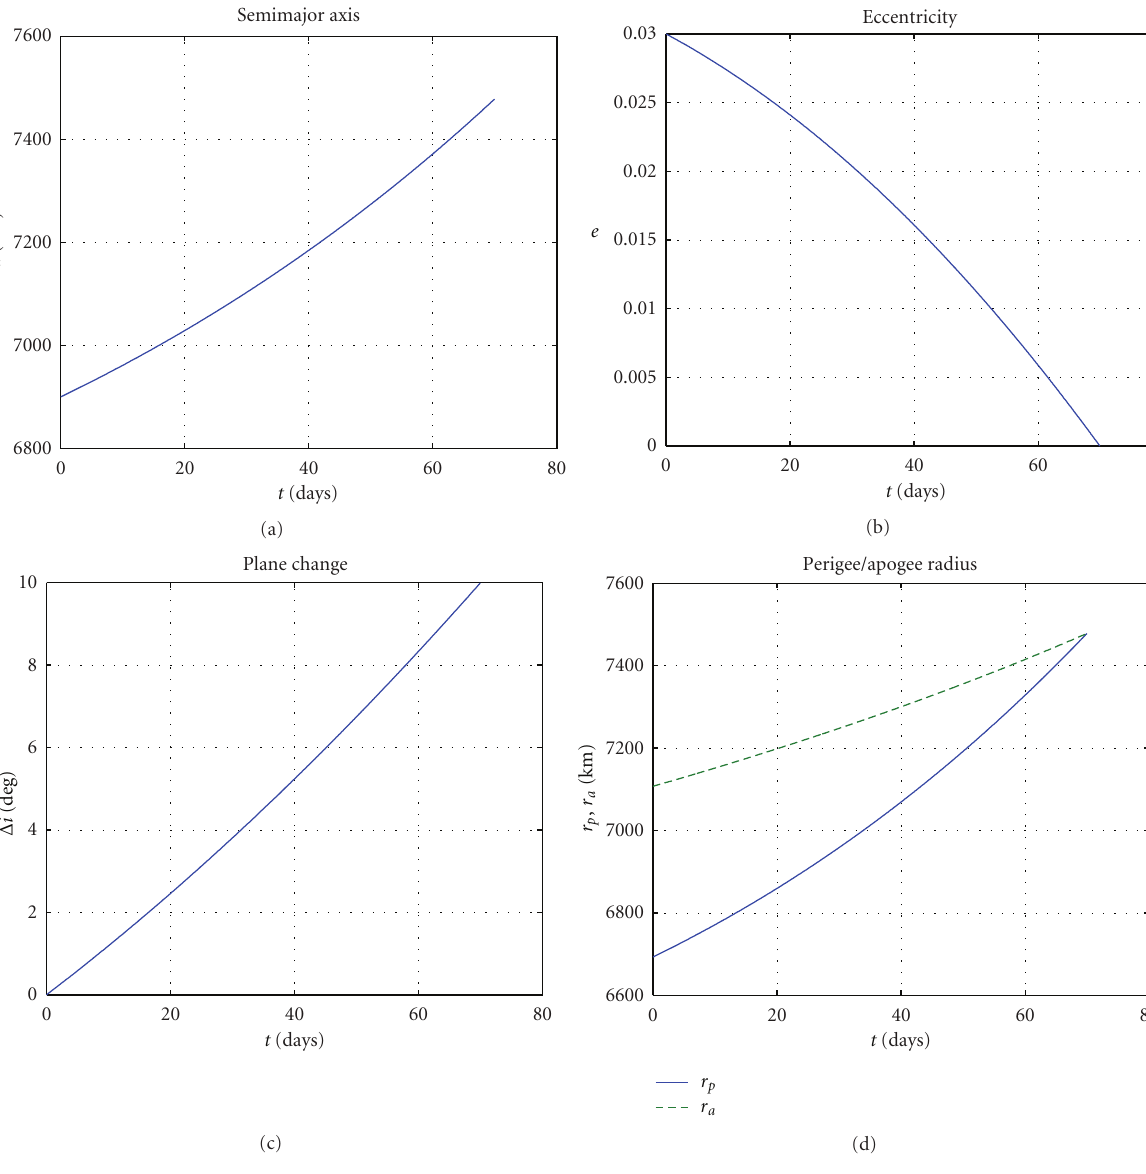
Figure 9: (a) variation of semi-major axis, (b) eccentricity, (c) plane change, (d) perigee, and apogee radiuses for multirevolution orbital transfer (10 ◦ plane change).